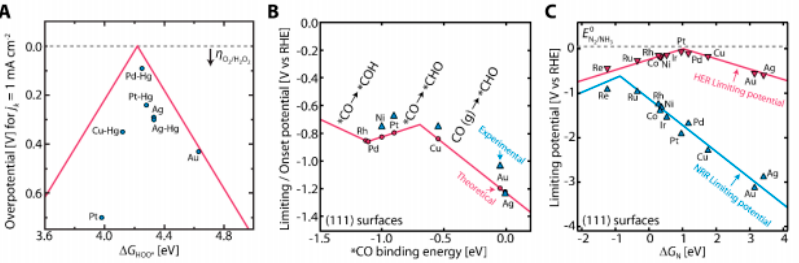
Figure 12. Emerging reactions of interest. ( A ) Volcano plot for hydrogen peroxide production on metals and alloys [254]. ( B ) Volcano plot for carbon dioxide reduction on metals [275,276]. ( C ) Volcano plot for nitrogen reduction on metals, with that of HER overlaid for comparison [286].